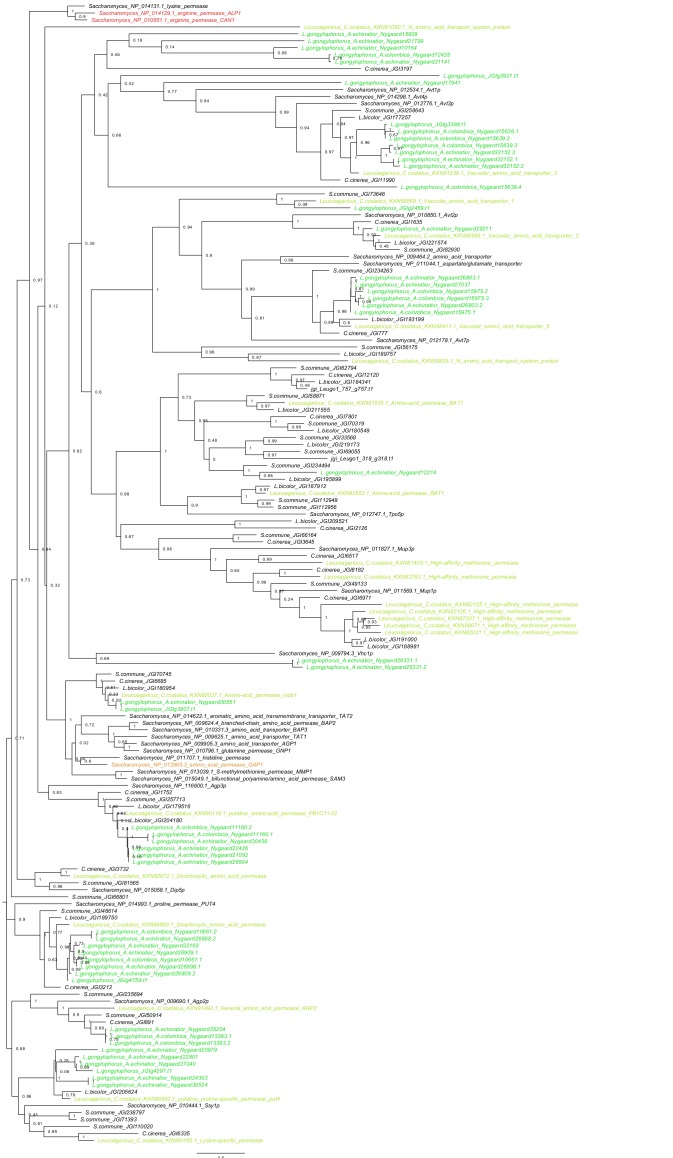
Phylogeny of all amino acid transporters in Saccharomyces, Agaricus bicolor, Coprinopsis cinerea, Schizophyllum commune and the Leucogaricus symbionts of Atta, Acromyrmex and C. costatus.Green and blue branches are Leucogaricus transporters, black are transporters documented for other multicellular basidiomycetes and unicellular Saccharomyces. Although Leucoagaricus fungal cultivars have a gltA gene that mediates the accumulation of environmental ammonium (Aylward et al., 2013; Macheda et al., 1999), their genomes appear to lack genes encoding the specialized Alp1 and Can1 proteins (red), which normally import arginine into fungal cells. This deficiency may have been instrumental in establishing metabolic complementarity between Mollicutes symbionts and the fungal cultivar, because the EntAcro-symbionts would catabolize excess arginine derived from the ants’ fungal food and possibly also from ingested plant sap as arginine may function as nitrogen-storage molecule in plants (Winter et al., 2015). This would imply that the ants gradually increase the gut-lumen ratio of NH3 to arginine from the midgut to the hindgut to ultimately release any excess nitrogen in a readily available form when they manure their fungus gardens. This hypothesis is somewhat challenged by the fact that closely related free-living basidiomycete fungi (Agaricus bicolor, Coprinopsis cinerea, Schizophyllum commune) also lack the genes encoding the specialized Alp1 and Can1 proteins, so this deficiency is not directly associated with life as a domesticated crop. It also appears possible that basidiomycete hyphae can import arginine, shown in a study of Agaricus bicolor (Kersten et al., 1999) that suggested the generic Gap1 protein (orange) can be used as alternative transporter. However, even if Leucoagaricus, and other fungi of the same clade, can utilize arginine, this would only happen if preferred nitrogen sources such as glutamine and ammonia (Ahmad et al., 1990; Abril and Bucher, 2004) are absent which does not seem very likely to happen, because an earlier study showed that the fecal droplets contain a mixture of allantoin, ammonia and most aminoacids (Martin and Martin, 1970).